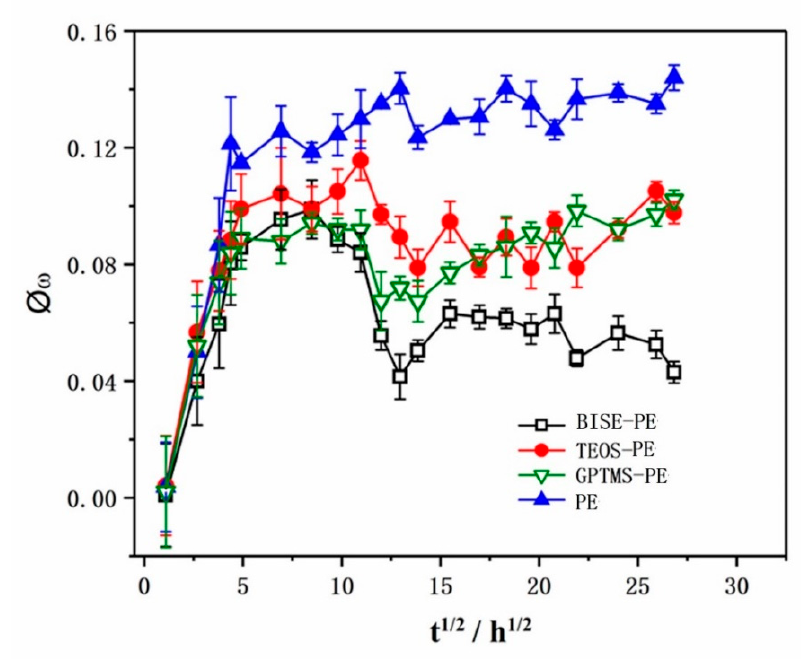
Figure 6. Evolution of water uptake of coatings.